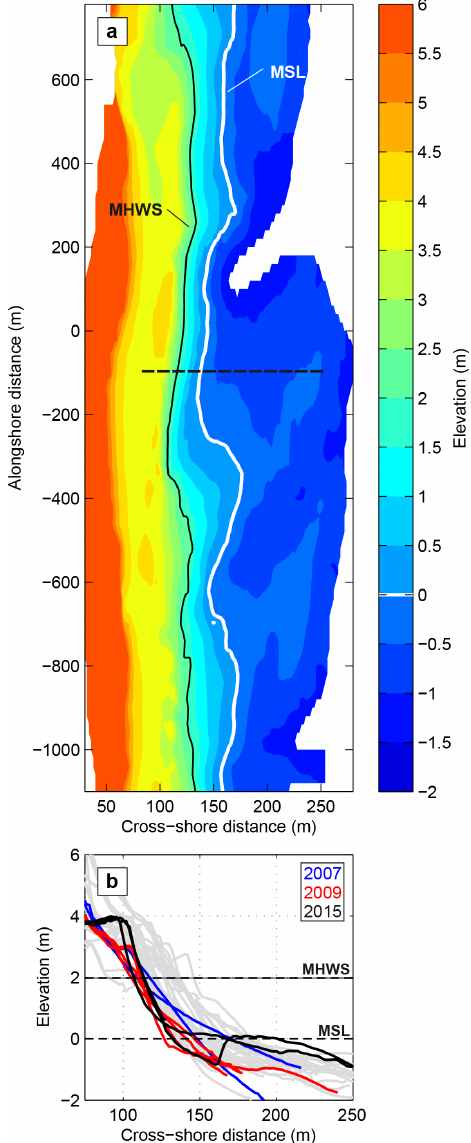
Figure 15. (a) Truc Vert beach morphology surveyed on 17 August 2015, with the colour bar indicating elevation in metres. (b) Su- perimposed alongshore-averaged summer (July–August) beach pro- files at Truc Vert beach since 2005 in grey, with the summers of 2007, 2009 and 2015